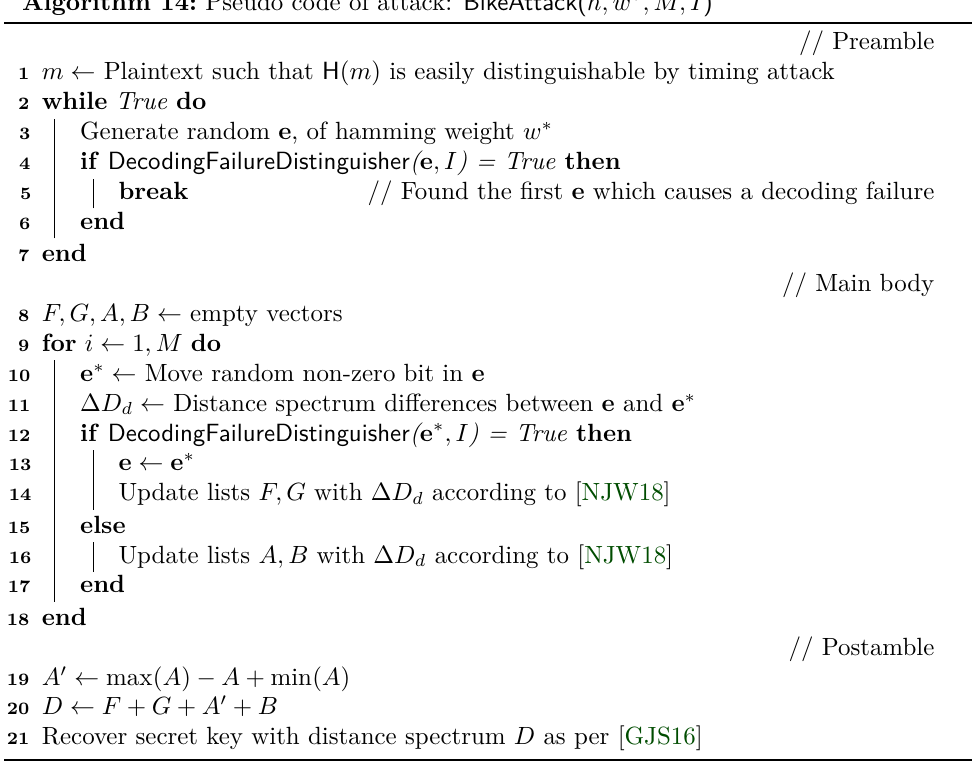
Algorithm 14: Pseudo code of attack: BikeAttack( h, w ∗ , M, I